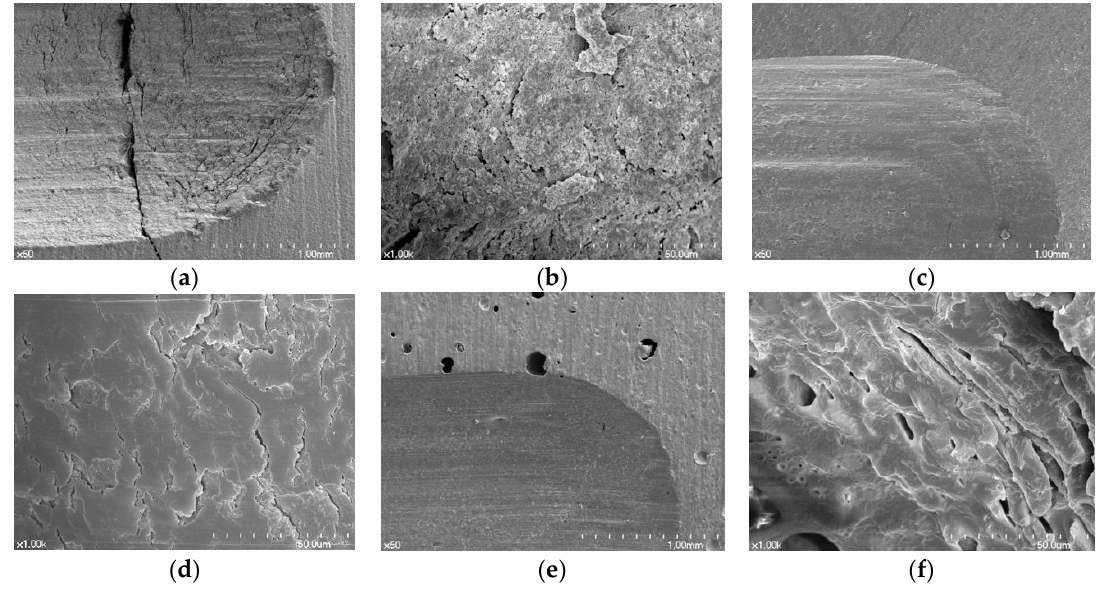
Figure 6. SEM images of the worn surfaces of the materials against the metal abrader. ( a ) 3D printed resin (original magnification ×50); ( b ) 3D printed resin (original magnification ×1000); ( c ) milled resin (original magnification ×50); ( d ) milled resin (original magnification ×1000); ( e ) self-cured resin (original magnification ×50); ( f ) self-cured resin (original magnification ×1000).